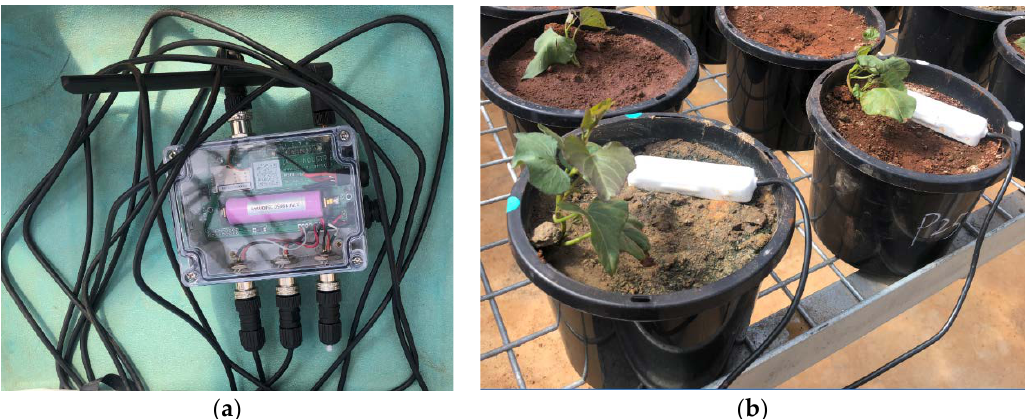
Figure 2. An example of a device with multiple sensors ( a ), with the ability to measure soil properties ( b ) (moisture, conductivity and temperature), air temperature and relative humidity. The device has a 2G/3G connectivity, and its web platform has an open Application Programming Interface (API) for ease of integration with other